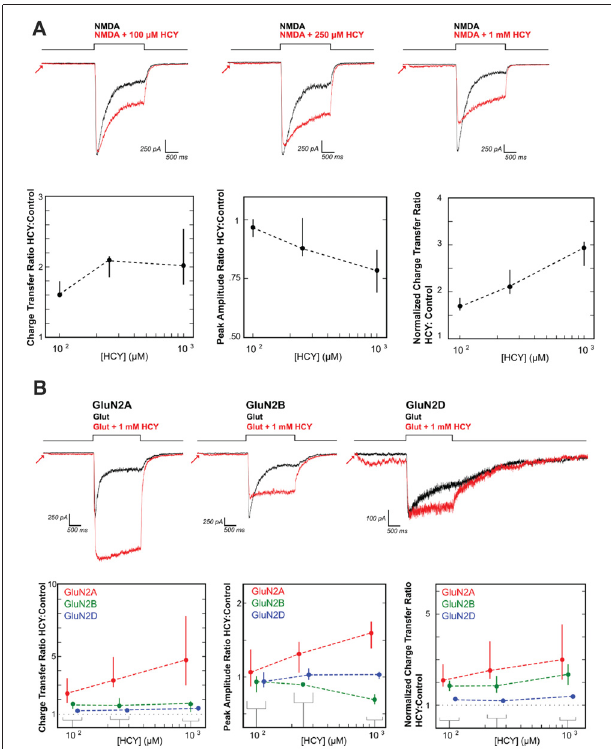
FIGURE 4 | HCY reduces NMDA receptor desensitization. (A) Voltage clamped neurons were maintained in 200 nM glycine. NMDA (100 µ M) was applied for 2 s both with HCY and without HCY on the same neuron. Increasing HCY concentrations decreased peak NMDAR current amplitude and reduced desensitization dose dependently. Notice that HCY still strongly reduced desensitization at one tenth of its maximal concentration (100 µ M = 50 µ M active L-HCY isomer; for [HCY] = 100 µ M, 250 µ M, 1 mM, N = 7, 5, 10). (B) HCY reduced desensitization of all three NMDAR subtypes transfected into HEK cells to make homogenous GluN2 NMDAR populations. The amplitude of GluN2A responses to glutamate was enhanced by the presence of HCY in a dose dependent manner. GluN2B, similar to NMDARs in young cultured neurons, showed dose dependent amplitude reduction by HCY. GluN2D showed no change in peak amplitude at any HCY concentration [N for each [HCY] (100 µ M = 50 µ M L-HCY isomer, 250 µ M = 125 µ M L-HCY isomer, 1 mM = 500 µ M L-HCY isomer): GluN2A N = 4, 5, 17; GluN2B N = 5, 5, 17 GluN2D N = 6, 3, 8]. Reprinted from Bolton et al.